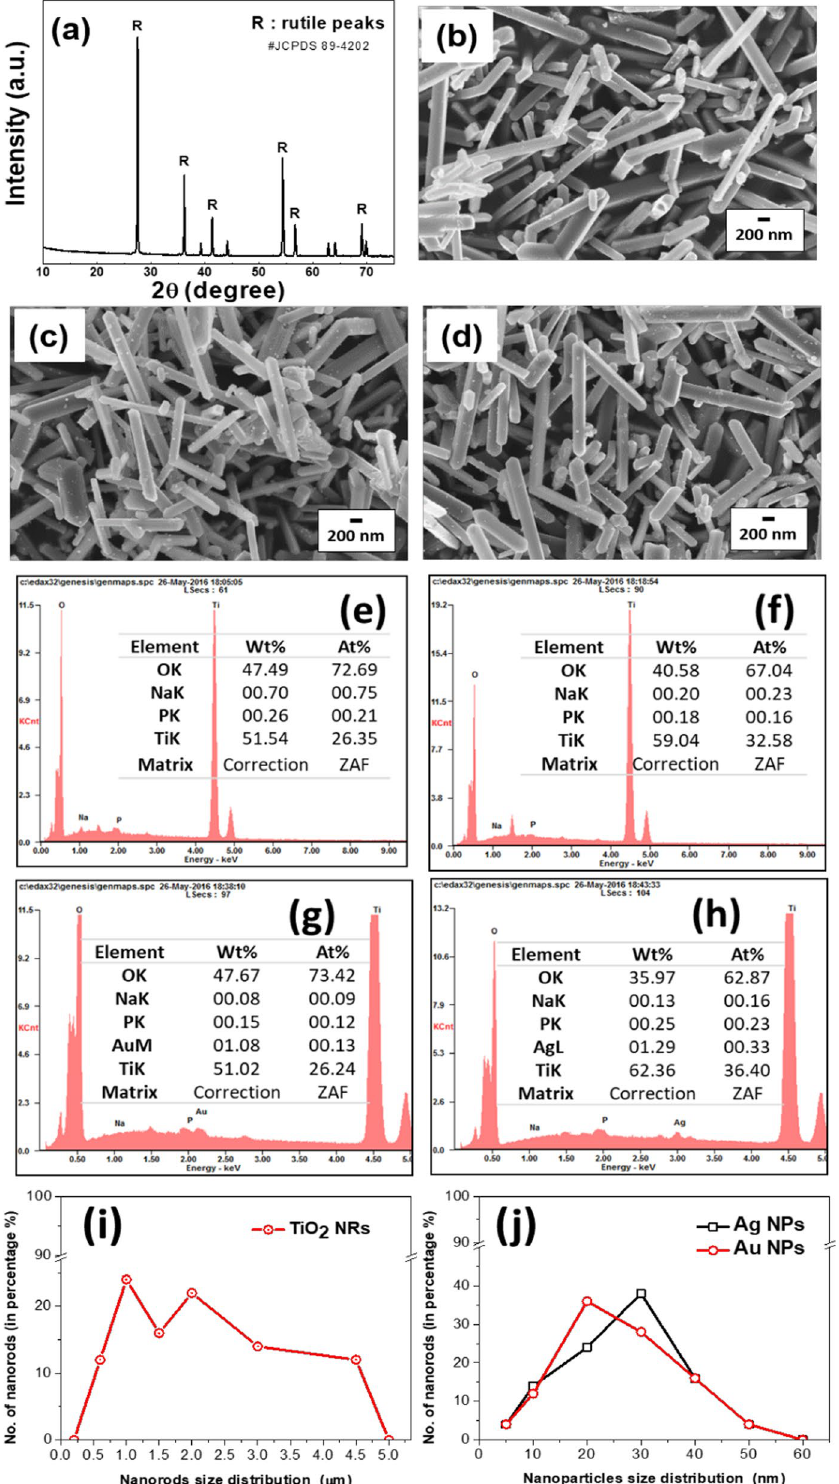
Fig. 1 Characteristics of novel metal‑loaded TiO 2 NRs. A XRD image of rutile TiO 2 NRs. FESEM images of B bare TiO 2 NRs, C Ag‑loaded TiO 2 NRs, and D Au‑loaded TiO 2 NRs. EDS spectrum and elemental quantification table (inset) of E TiO 2 ‑NRs, F 2‑time washed TiO 2 ‑NRs, G Au (1wt%)‑TiO 2 ‑NRs, and H Ag (1wt%)‑TiO 2 ‑NRs. Particle size (length) distribution histogram for I TiO 2 NR, and J deposited noble metals (Au and